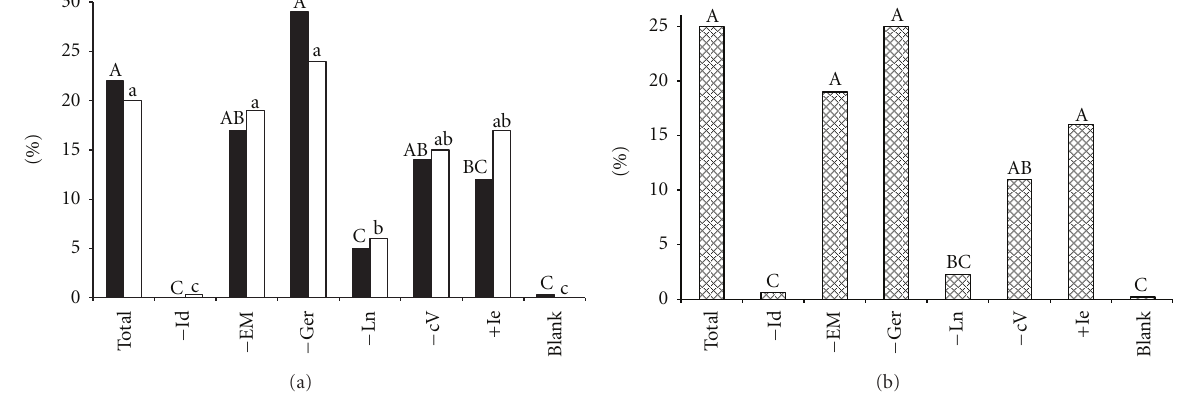
Figure 6: Percentage trap-catches in a subtractive and additive field bioassay of I. pini -bait: (a) I. pini (b) I. avulsus . (for bait information, see Table 3). (cid:2) females; (cid:3) males. Bars with same letter are not significantly di ff erent. n = 5; total trap catches: I.pini 602 ♀♀ , 296 ♂♂ ; I. avulsus 7,000 ♀♀ + ♂♂